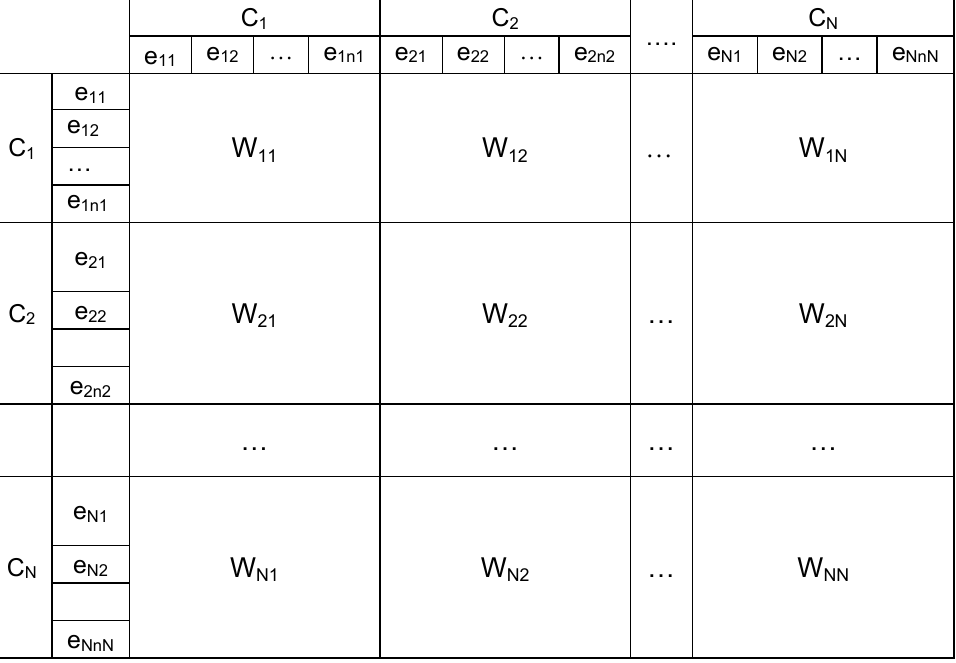
Figure 2. Supermatrix general structure (Source: elaboration from Bottero et al.,